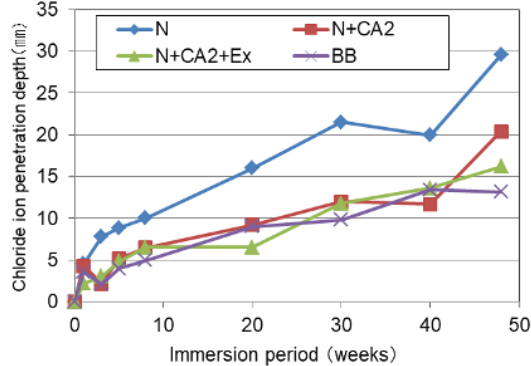
Figure 1. Salt immersion test